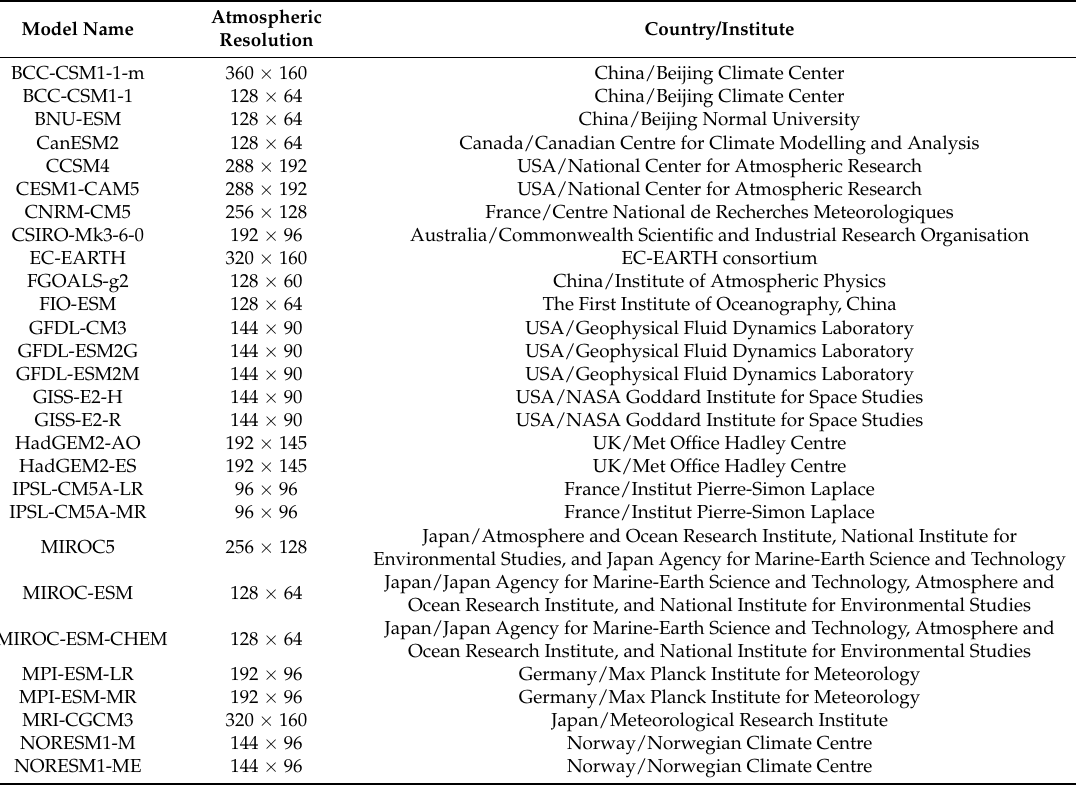
Table 1. Information for the general circulation models (GCMs) used in this